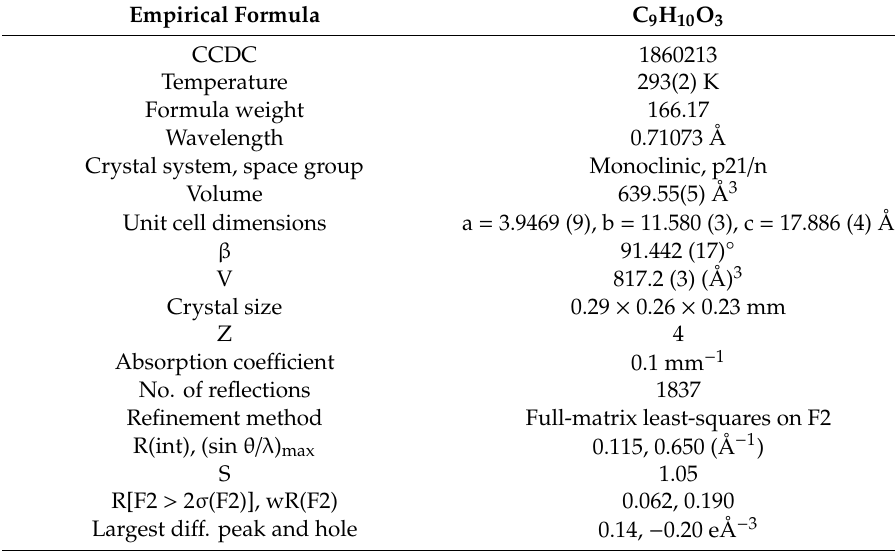
Table 1. Crystallographic refined parameters of the desired molecular